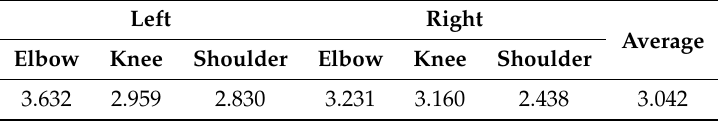
Table 4. Mean Absolute Error (MAE) in the estimated and the ground-truth angle orientations of different body